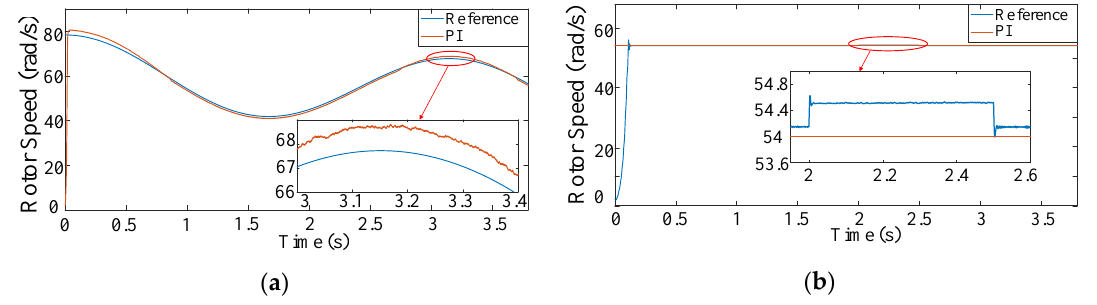
Figure 2. Rotor speed response under swell effect and turbine torque disturbance. ( a ) Rotor speed under swell effect; ( b ) rotor speed under turbine torque disturbance.